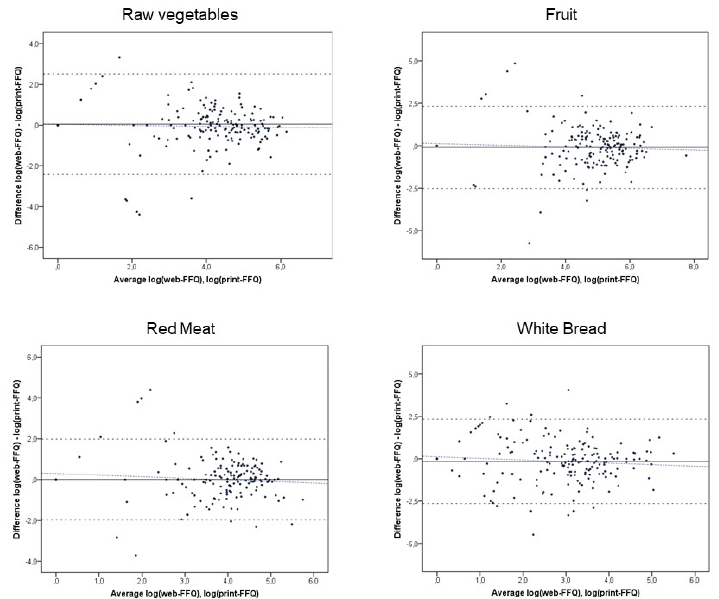
Figure 1. Bland-Altman plots of individual differences in food intakes (raw vegetables, fruit, red meat and white bread) between the web-FFQ and print-FFQ against their averages; the upper and lower 95% limits of agreement (dashed lines), mean agreement (solid line) and regression slope (blue dashed line) are indicated.